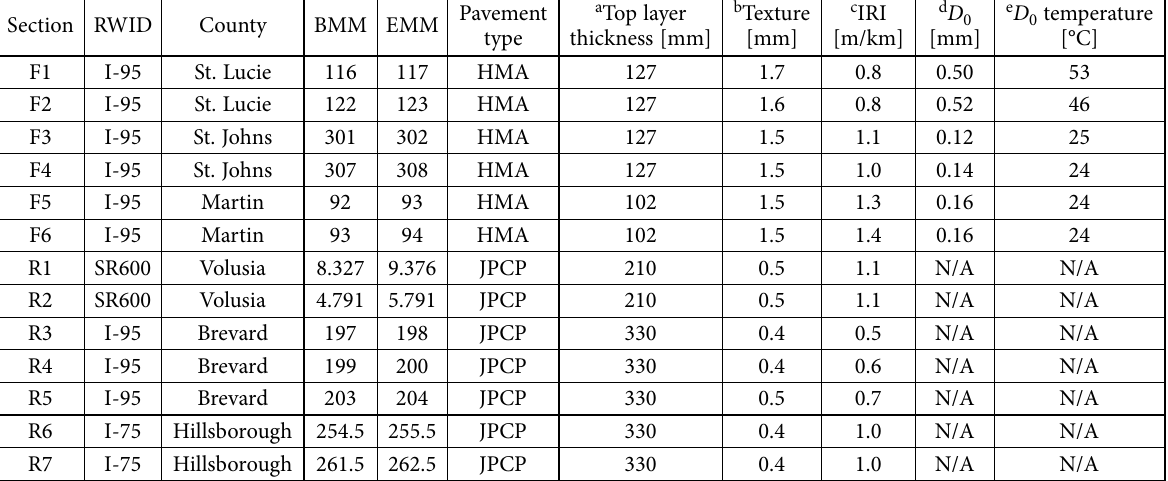
Table 1. Summary of roadway and pavement information Section